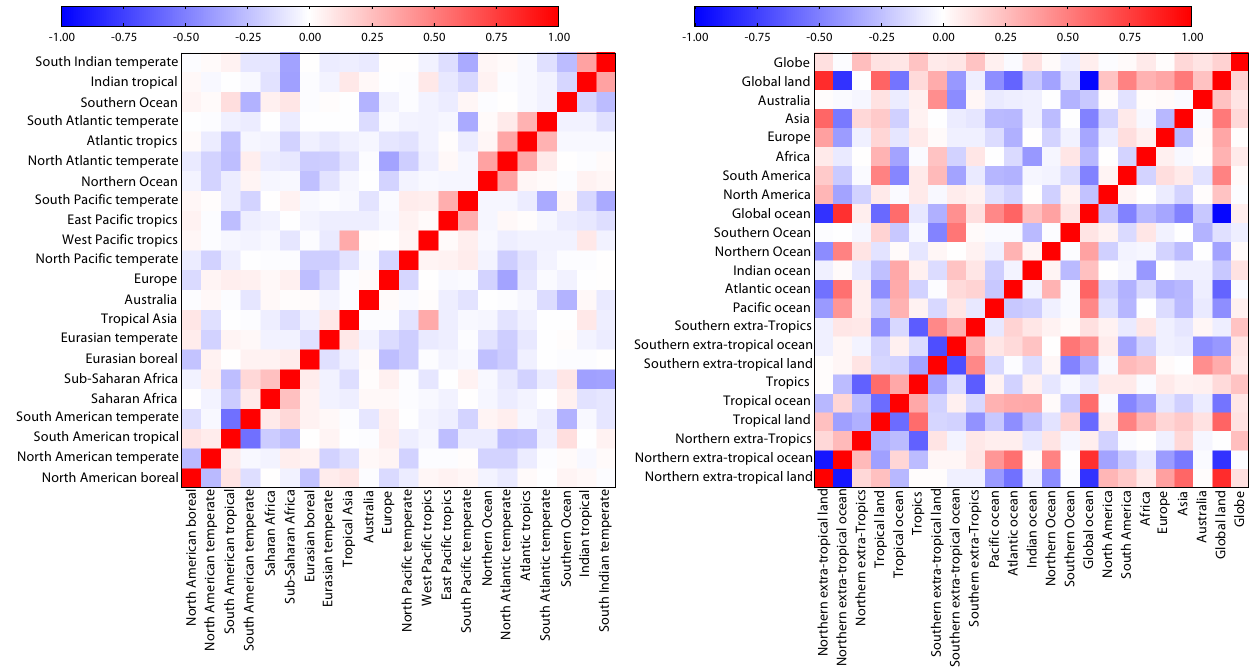
Fig. 9. The posterior correlation matrix between optimized emissions shown in Figs. 7 and 8. On the left are the 22 TRANSCOM regions, and on the right are larger regions comprised of several TRANSCOM regions. These matrices correspond to the inversion assimilating both GOSAT and surface layer CO 2